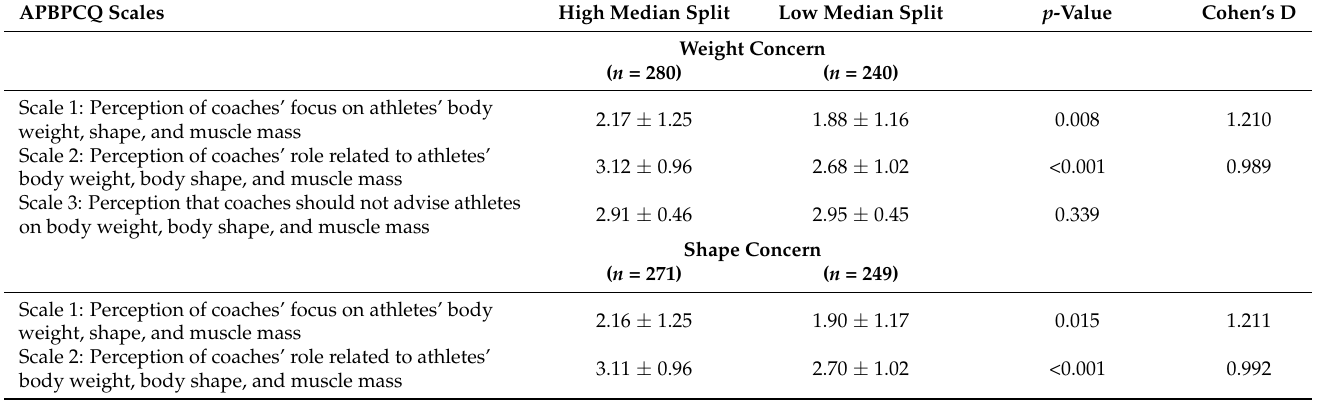
Table 7. Comparison of Athletes’ Perceived Body Pressures from Coaches Questionnaire by Weight Concern, Shape Concern, and Achievement Orientation in Males ( n =